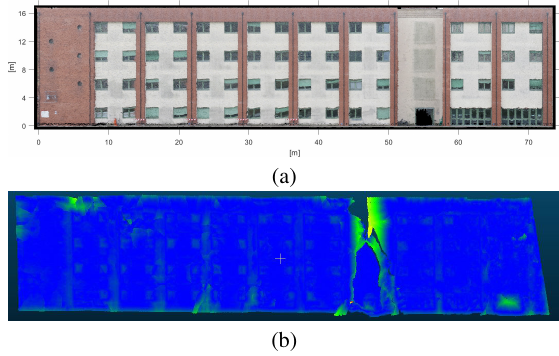
Figure 4. (a) Orthophoto of the building fac¸ade considered as case study. (b) Comparison between cloud points generated by Agisoft PhotoScan and the presented Matlab